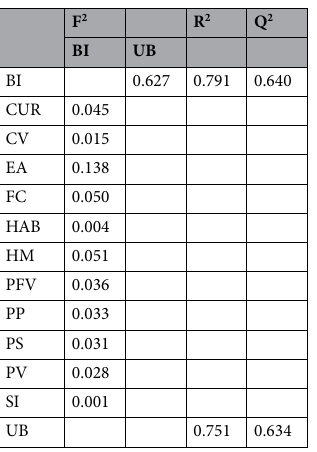
Table 4. Effect size, Predictive relevance, and coefficient of